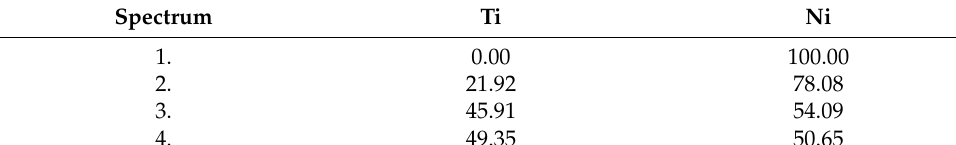
Table 9. EDS point analysis weld 10 (nickel–weld metal interface) (in at. %). Spectrum